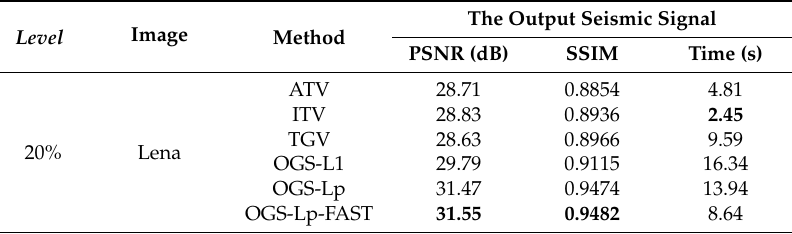
Table 2. Numerical comparison of our proposed method and other models (images are corrupted by impulse noise of 20%). ATV: anisotropic total variation; ITV: isotropic total variation; TGV: total generalized variation; OGS-L1: overlapping group sparsity with L1-norm; OGS-Lp: overlapping group sparsity with